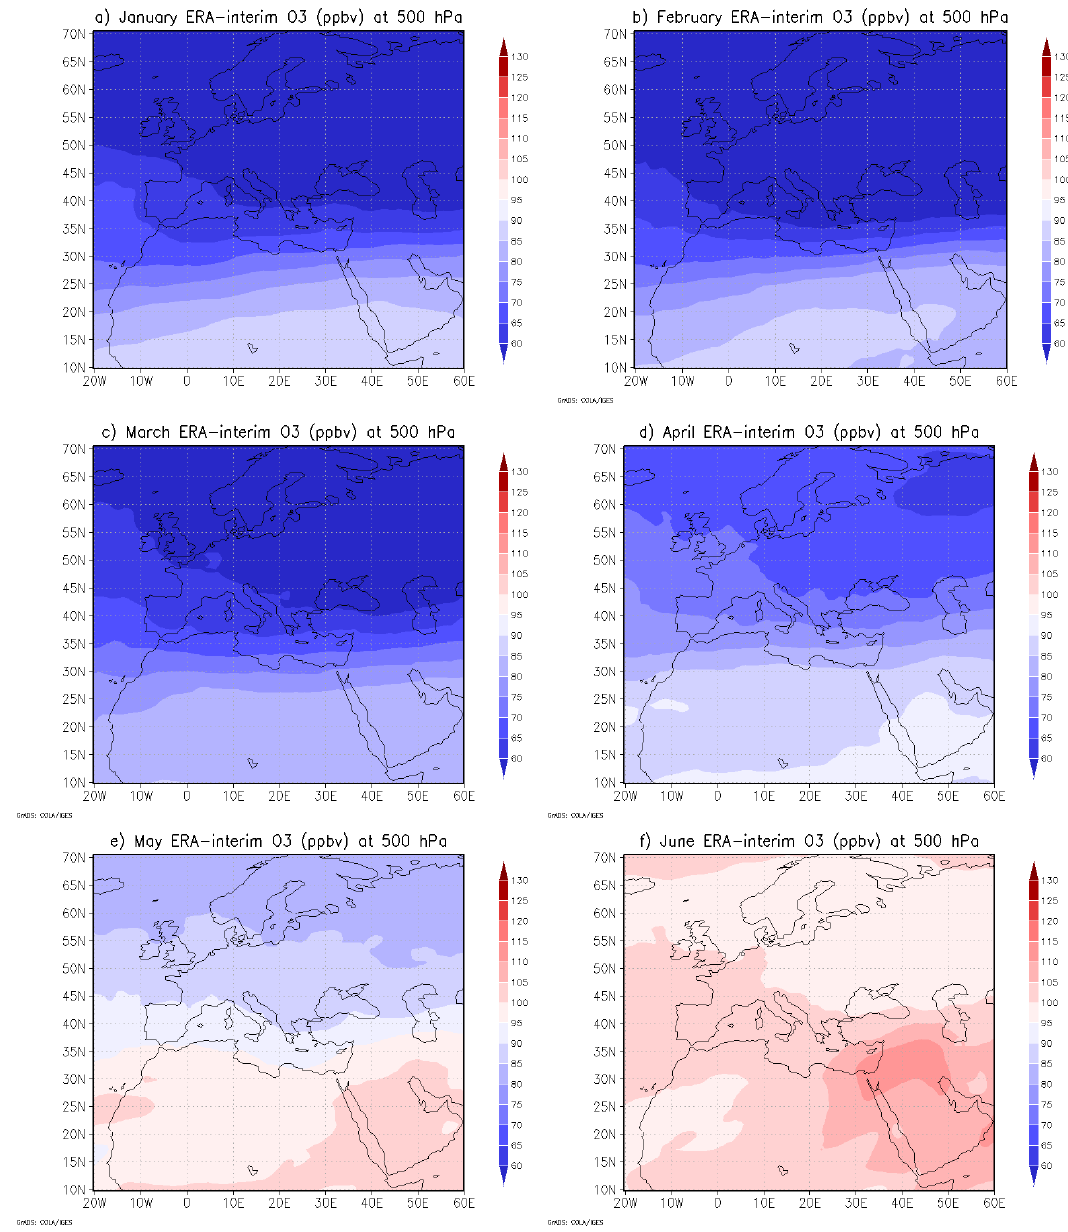
Fig. 2. Monthly average ozone fields at 500hPa based on ERA-Interim ozone (ppbv) over the period 1998–2009 for (a) January, (b) February, (c) March, (d) April, (e) May, (f) June, (g) July, (h) August, (i) September, (j) October, (k) November, (l) December. Figure 2. Monthly average ozone fields at 500 hPa based on ERA-interim ozone 876 (ppbv) over the period 1998-2009 for a) January, b) February, c) March, d) April, e) 877 of both TES and ERA-Interim ozone fields clearly corrob- May, f) June, g) July, h) August, i) September, j) October, k) November, l) December. 878